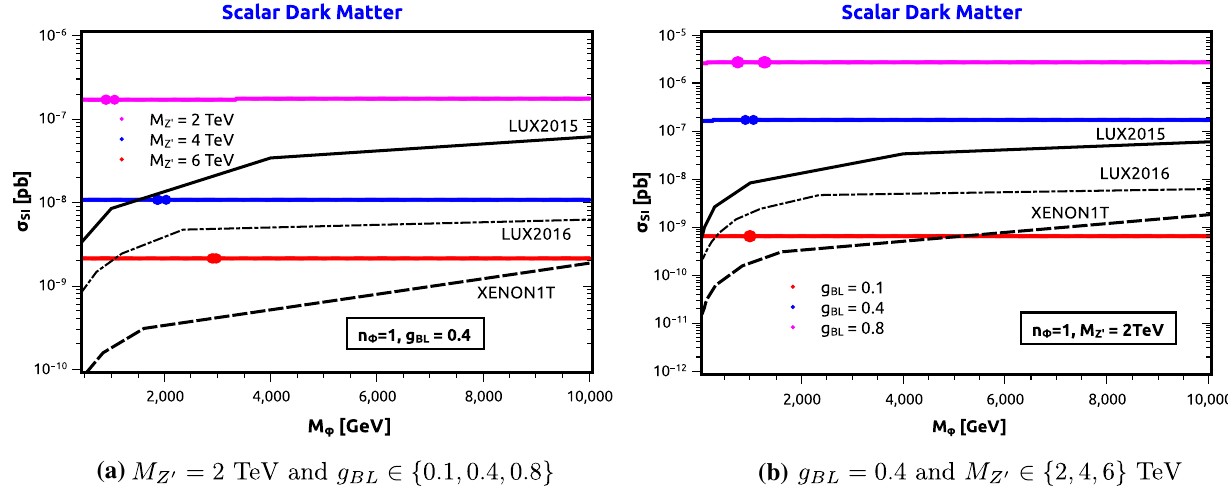
Fig. 6 Scalar field. Scattering cross section as a function of the dark matter mass for n = 1 and various values of M Z (cid:2) and coupling g BL . Predictions are compared to current and projected bounds from LUX-2015 ( solid ), LUX-2016 ( dotted-dashed ) and XENON1T ( dashed )